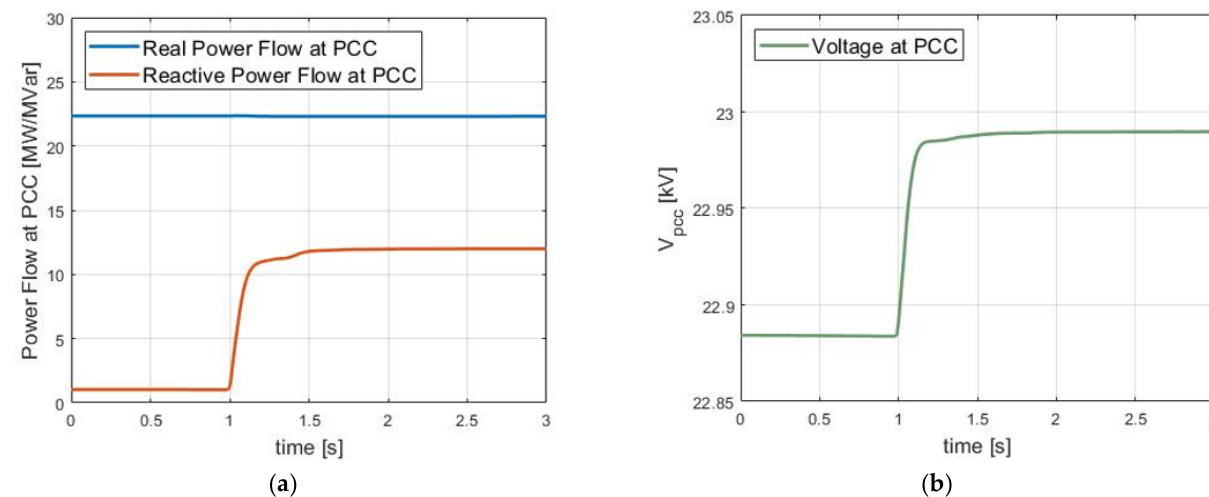
10 of 15 Figure 6. Simulation Configuration with RTDS and Raspberry PI . Figures 7 and 8 indicate the simulation results for the case when the step change of the reactive power reference to the wind farm occurs from the initial value (0 MVAr) to the control target value (12 MVAr) as shown in the relevant case study in Table 2. Figure 7 shows the real/reactive power flow and voltage at the PCC. The PCC voltage change is observed after a step change of the reactive power reference for the wind farm. After the optimization process of the reactive power allocation for each array, the reactive power references to be allocated to wind turbines are calculated by multiplying the allocation ratios as shown in Equation (9), which can be represented in Figure 8. In Figure 8 (d), when the assigned reactive power reference of the entire wind farm is 12 MVAr, it can be seen that the calculated reactive power reference of the sixth wind turbine is beyond the reactive power capacity limit of the wind turbine, and the reactive power reference for the wind turbine is assigned a maximum output of 1.323 MVAr, which is the reactive power limit in the case of 1.5 MW of real power output. It indicates that although the reactive power outputs of some wind turbines are beyond their reactive power limits; the wind farm controller reads the reactive power flow at the PCC and allocates additional reactive power to other wind turbines. Table 2. Case study information .